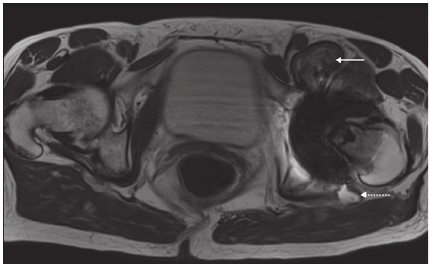
Figure 18: Adverse reaction to metallic debris (ARMD). A 70-year- old female with left hip resurfacing complicated by pseudotumour formation. Axial T2 pelvis with metal artefact reduction technique demonstrating distension of the left hip pseudocapsule posteriorly (dotted line) and a larger anterior pseudocapsule defect decom- pressing into the iliopsoas bursa (arrow). This thickened, T2- hypointense rim with synovial proliferation favours pseudotu- mour/ARMD over